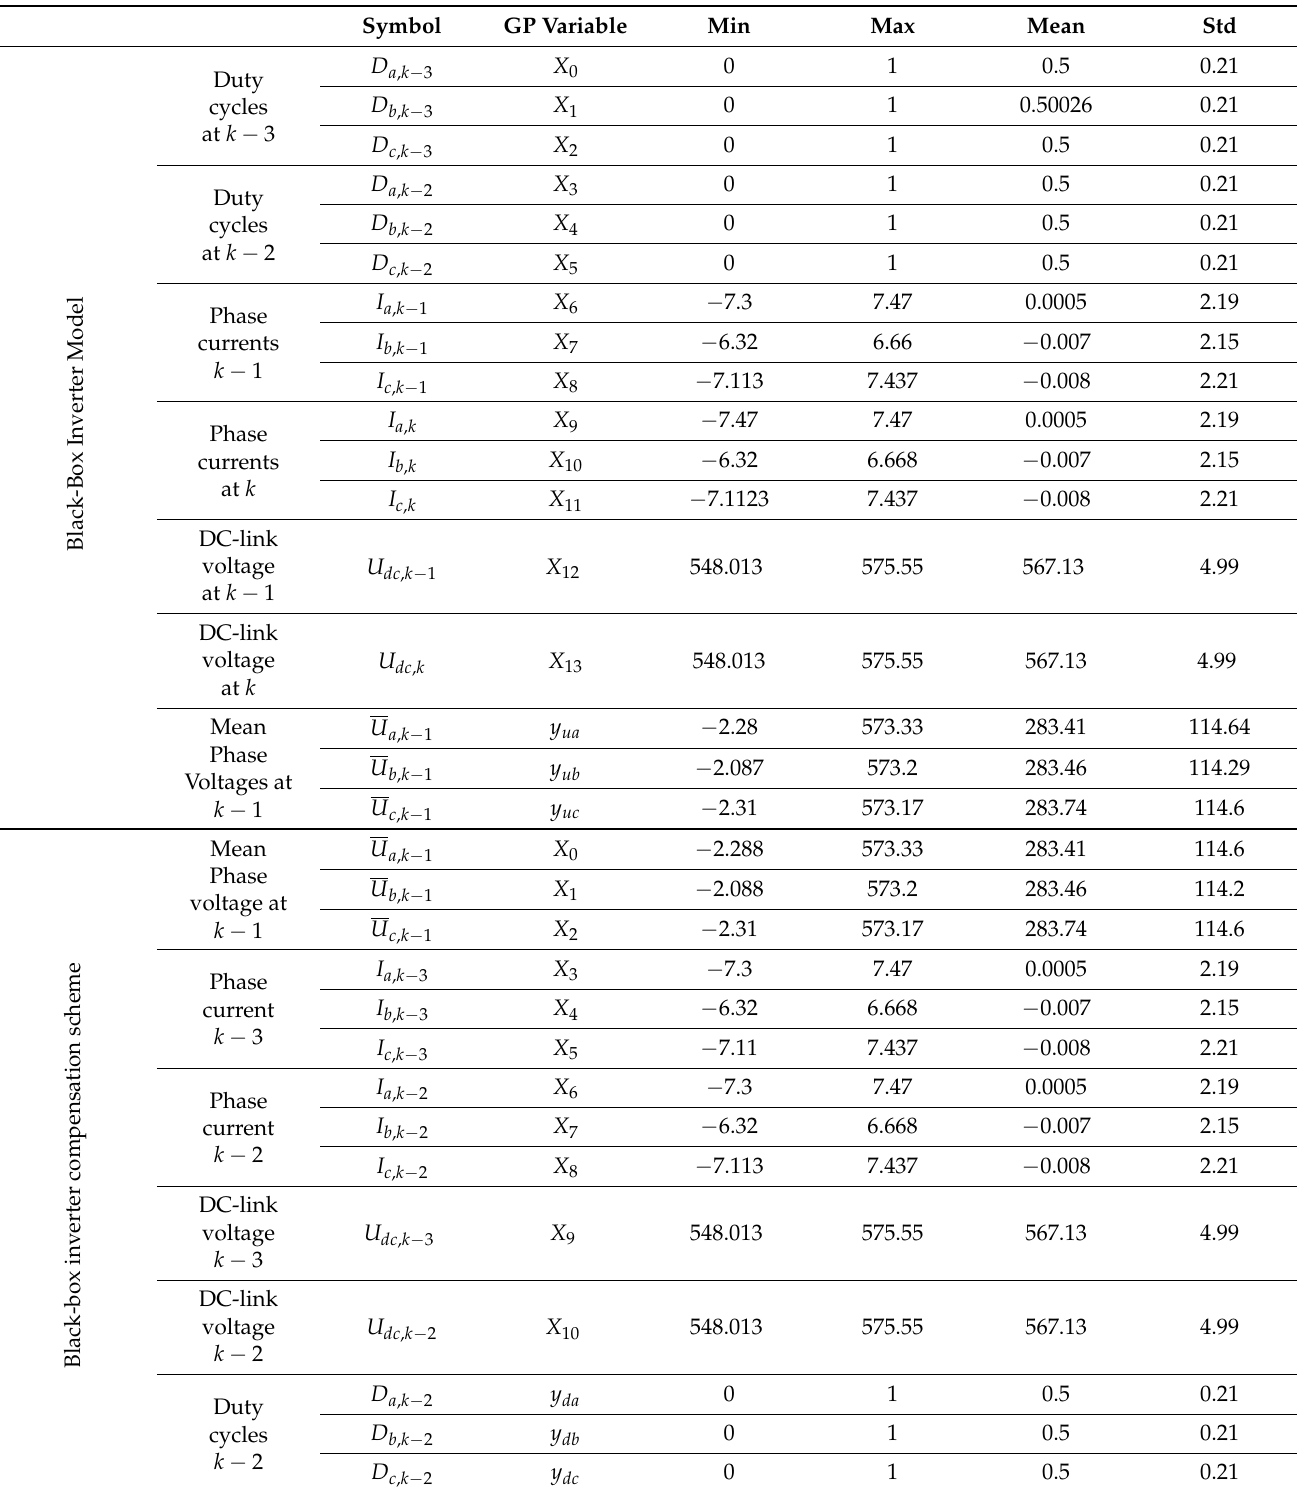
Table 2. The list of input and output variables that were used in GP for the black-box inverter model and black-box compensation scheme. The symbolic representation of input and output variables in GP was given as well as the results of statistical analysis (minimum, maximum, mean and standard deviation values) for each